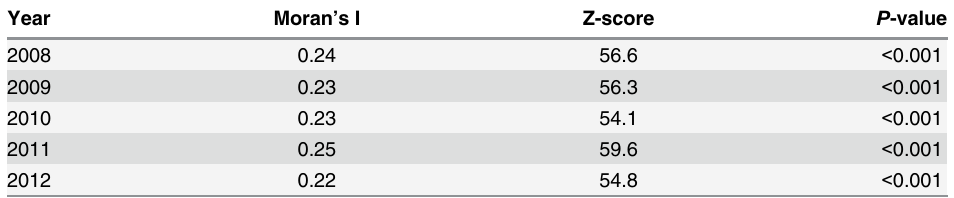
Table 1. Results of the spatial autocorrelation test on HFMD incidences at the county level in main- land China, 2008 –